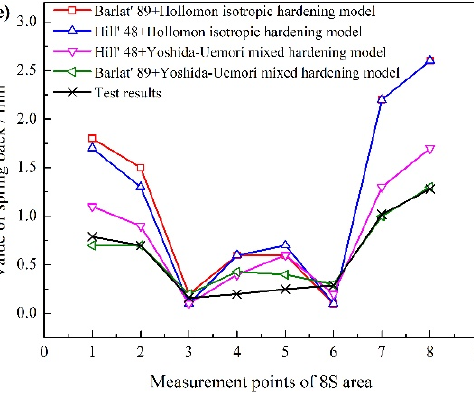
Figure 7. The comparisons between prediction results and the test results: ( a ) 4S area, ( b ) 5S area, ( c ) 6S area, ( d ) 7S area, and ( e ) 8S area.